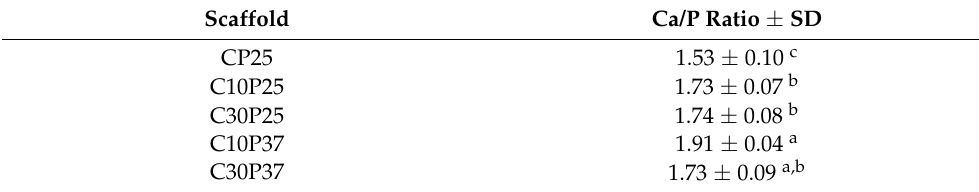
Table 5. Ca/P ratio for biomineralized scaffolds.